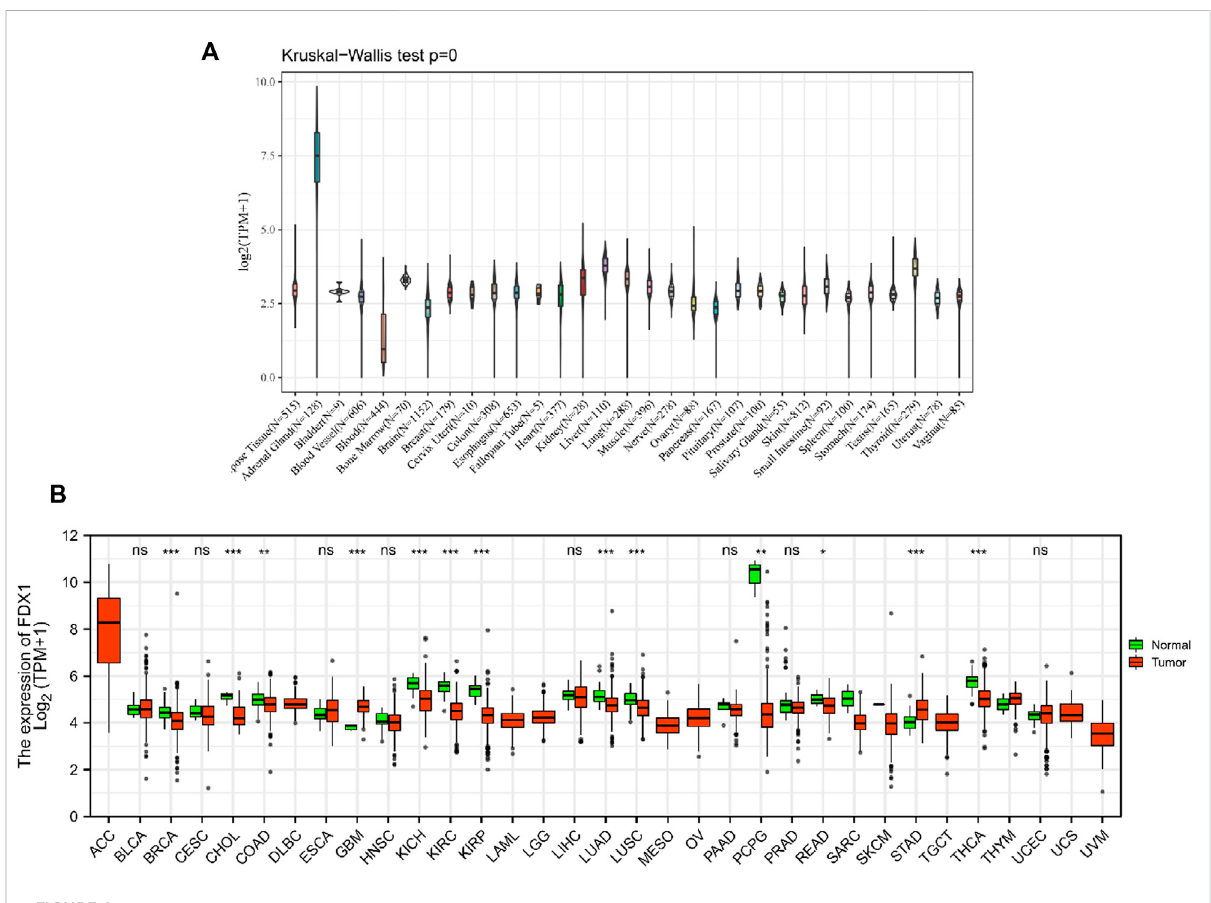
FIGURE 1 mRNA expression levels of FDX1 from different tissue sources and tumors. (A) normal mRNA expression levels of FDX1 in various tissues from the GTEx database. (B) differences in FDX1 mRNA expression between tumor and peritumoral samples from the Cancer Genome Atlas database. Abbreviations:BLCA,bladderurothelialcarcinoma;CESC,cervicalandcervicalcancer;CHOL,cholangiocarcinoma;COAD,colonadenocarcinoma; DLBC, lymphoid tumor diffuse large B-cell lymphoma; ESCA, esophageal cancer; HNSC, head and neck squamous cell carcinoma; KIRP, renal papillary cell carcinoma; LUAD, lung adenocarcinoma; LUSC, lung squamous cell carcinoma; PAAD, pancreatic cancer; PCPG, pheochromocytoma and paraneurysm; PRAD, prostate adenocarcinoma; reading, rectal adenocarcinoma; SARC, sarcoma; STAD, gastric adenocarcinoma; STES, gastric and esophageal cancer; TGCT, testicular germ cell tumor; THCA, thyroid cancer; THYM, thymoma; UCEC, endometrial cancer of the uterus; UCS, uterine